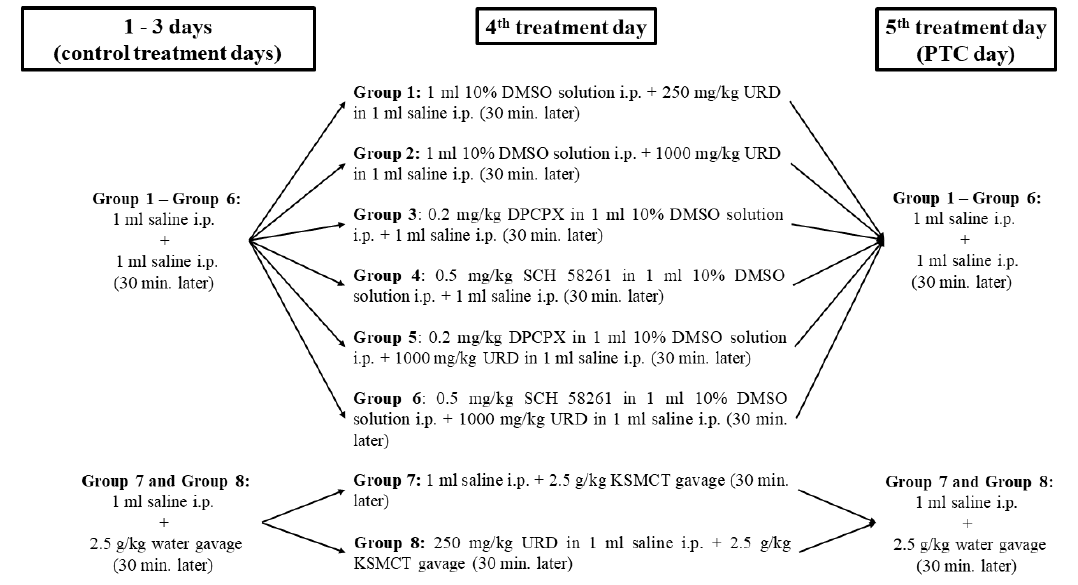
Figure 1. Details of the experimental protocol of the 8 treatment groups. Abbreviations: DMSO, dimethyl sulfoxide; DPCPX, 1,3-dipropyl-8-cyclopentylxanthine; Group: animal group; i.p., intraperitoneal; KSMCT, mix of ketone salt (KS) and medium chain triglyceride (MCT) oil in a 1:1 ratio; PTC day, post-treatment control day; SCH 58261, (7-(2-phenylethyl)-5-amino-2-(2- furyl)-pyrazolo-[4,3-e]-1,2,4-triazolo [1,5-c]pyrimidine); URD,